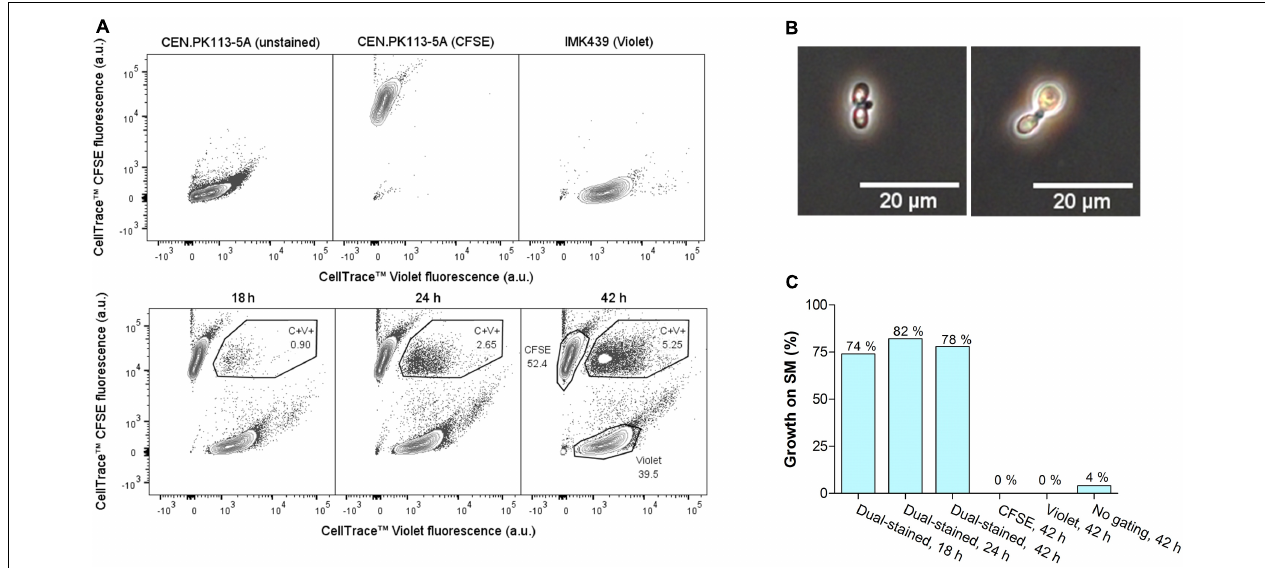
FIGURE 1 | Intra-species mating of S. cerevisiae strains CEN.PK113-5A ( MATa URA3 his3- (cid:49) 1 leu2-3,112 trp1-289 ) and IMK439 ( MAT α HIS3 TRP1 LEU2 ura3 (cid:49) ::KanMX ). (A) Fluorescence contour plots of unstained CEN.PK113-5A, CEN.PK113-5A stained with CellTrace TM CFSE, IMK439 stained with CellTrace TM Violet, and of the mating culture after 18, 24, and 42 h. The indicated gated areas were used for sorting cells, event rates of each gate are indicated as a percentage of total cell counts. (B) Microscope image (400 × ) of zygotes sorted from the double-stained population (C+V+) after 42 h of mating. (C) Percentage of cells able to grow on synthetic medium without auxotrophy-complementing supplements in different populations sorted by FACS, as indicated in (A) .